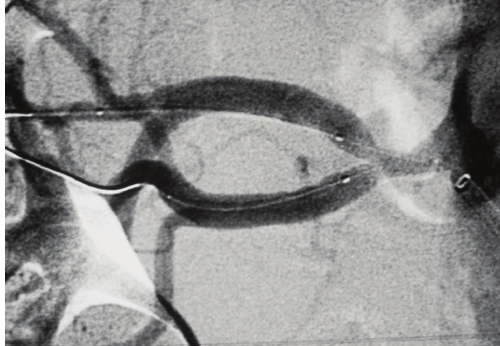
Figure 3: After two-balloon dilated stent placement image, with a good angiographic imaging